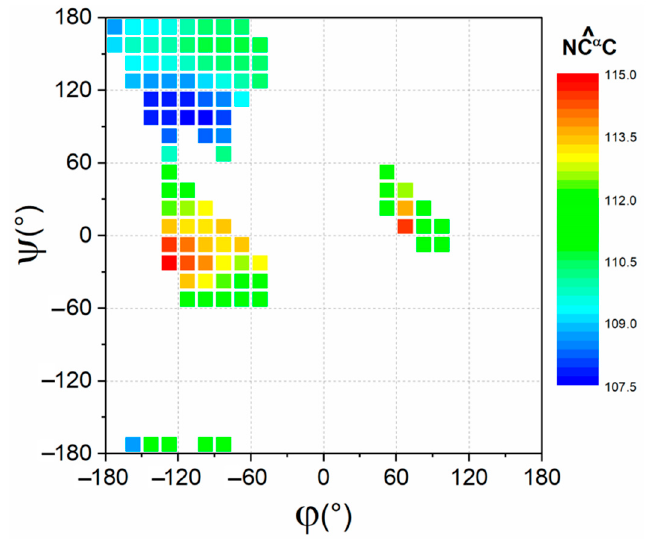
Figure 10. Ramachandran plot highlighting the dependence of the backbone bond angle τ (NC α C) on conformation ( φ , ψ ). The experimental values are calculated in the dataset Data1.6 by averaging the angles of non-Pro/non-Gly residues in the ( φ , ψ ) boxes. Only boxes containing more than 500 residues were considered.